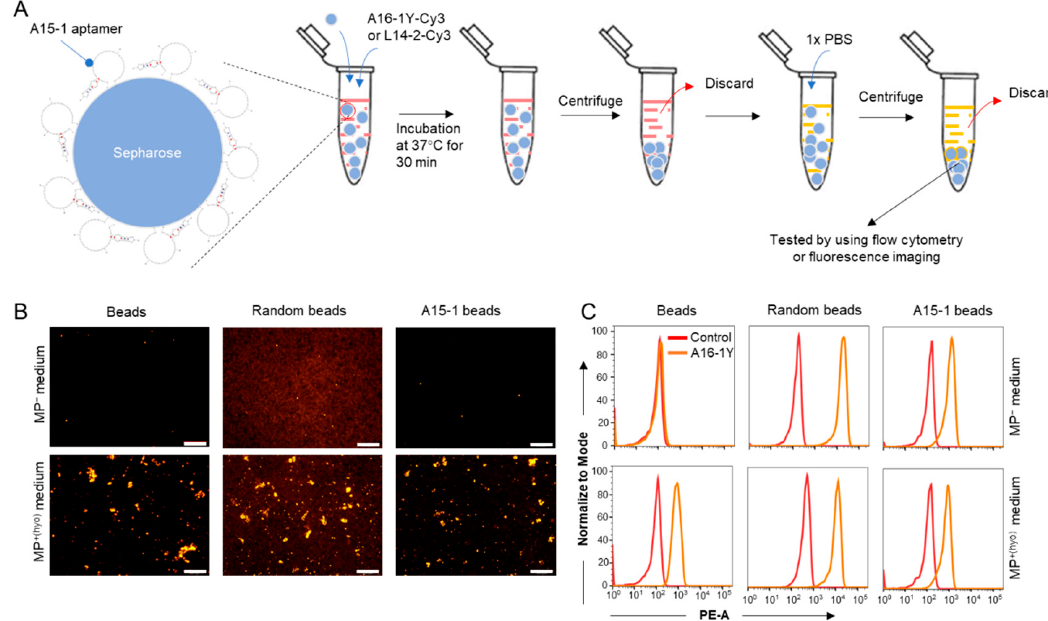
Figure 8. Detection of mycoplasma ‐ contaminated culture medium. Streptavidin ‐ immobilized sepharose and the A16 ‐ 1Y aptamer were used to distinguish between MP + and MP − cell culture media. ( A ) Flow chart of the experiments for mycoplasma detection in cell culture medium. Indicator beads were incubated with MP − or MP + cell culture medium containing [100 nM] Cy3 ‐ labeled A16 ‐ 1Y or control aptamer at 37 °C for 30 min. Then, the fluorescence of those aptamer ‐ bound beads was observed using a fluorescent microscope or a flow cytometer. Red in the tube indicates cell culture medium, yellow in the tube indicates 1 × PBS. ( B ) Fluorescence microscopy observation of the Cy3 ‐ labeled A16 ‐ 1Y aptamer binding with M. hyorhinis ‐ adherent sepharose. ( C ) Histogram plots of flow cytometric data representing Cy3 ‐ labeled A16 ‐ 1Y aptamer binding with M. hyorhinis ‐ adherent sepharose. Scale bar = 500 μ m.